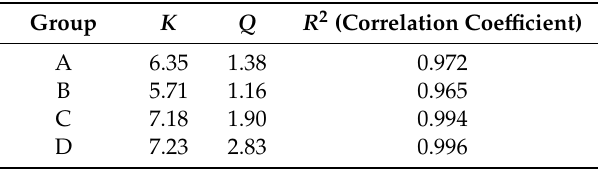
Table 5. Linear fitting results for group A, B, C and D.